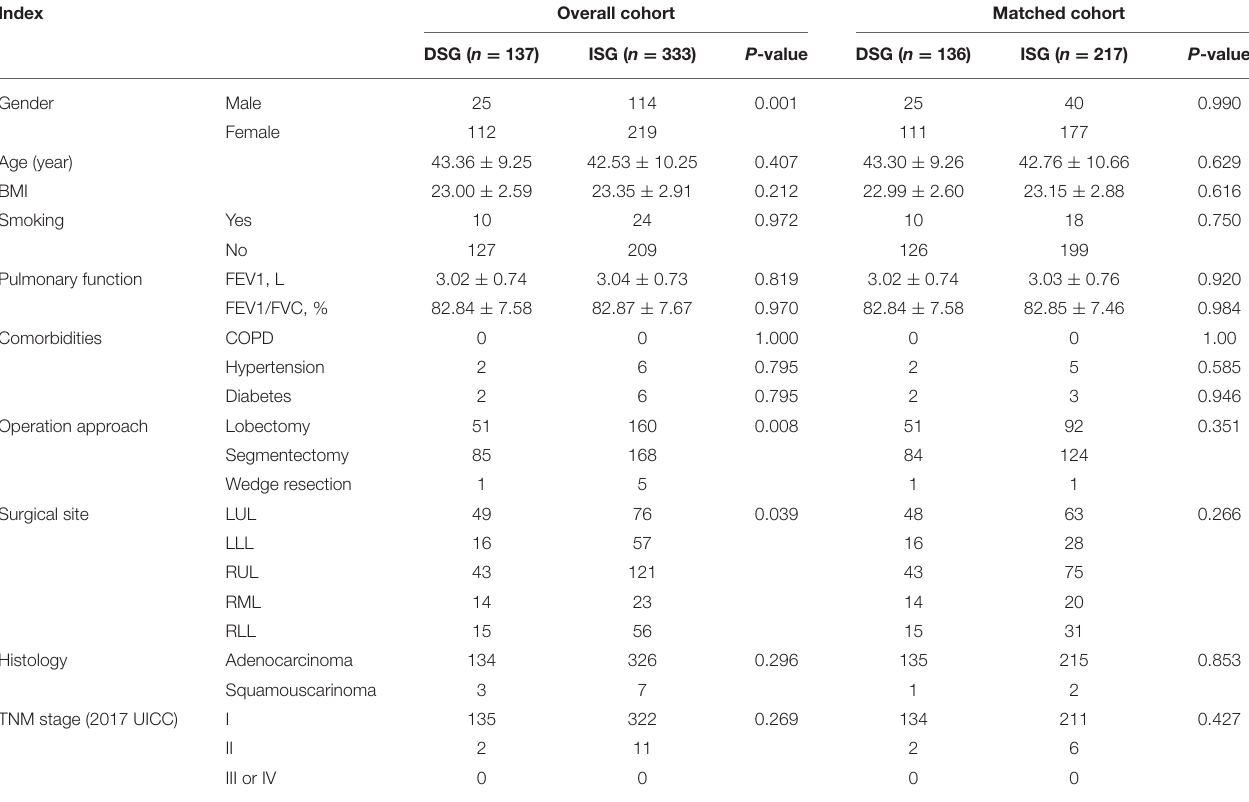
TABLE 1 | Population characteristics of in two groups before and after propensity score matching.